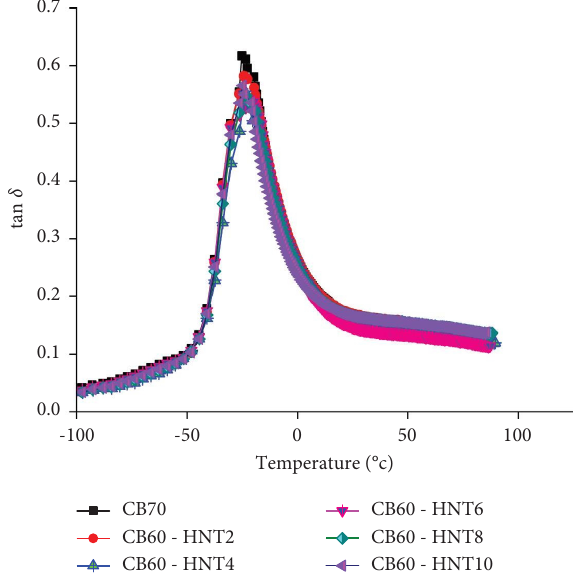
Figure 13: Deviation of loss factor (tan δ ) vs.